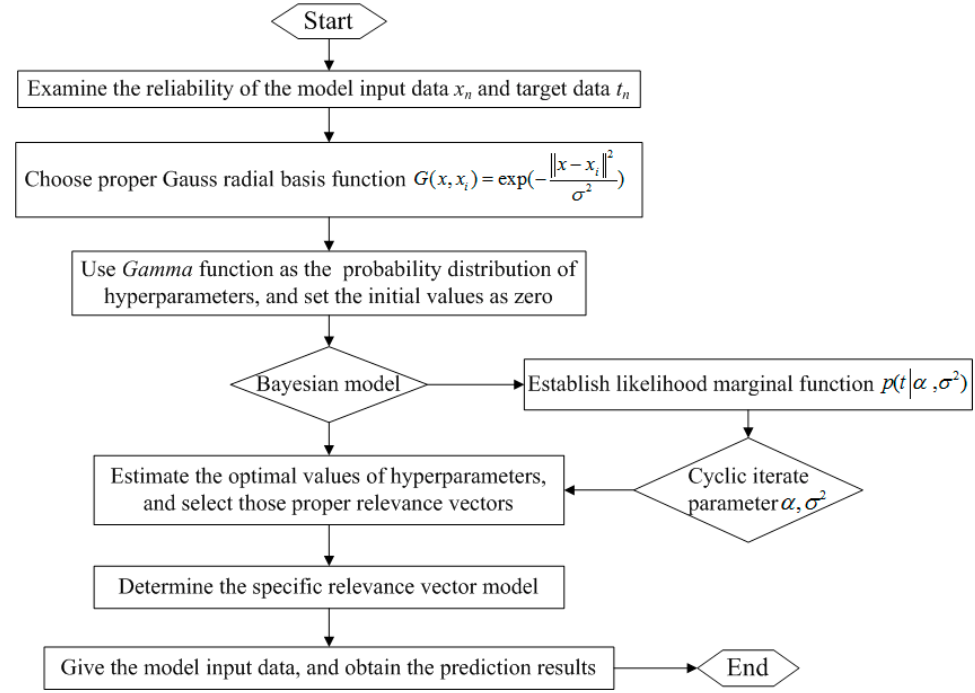
Figure 1. Flow chart of the forecasting process of hydrological variables using the Relevance Vector Machine (RVM) model.